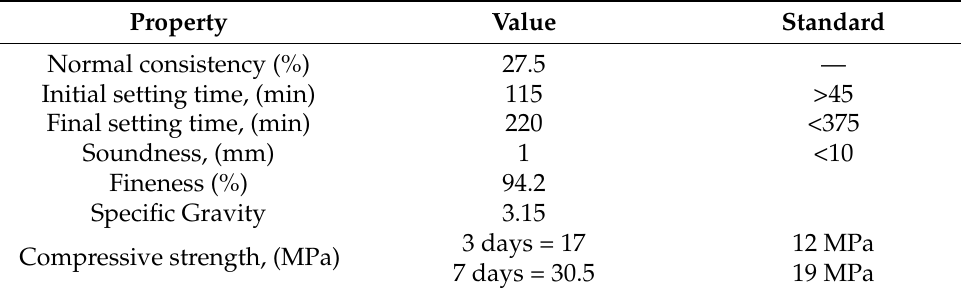
Table 1. Physical and mechanical properties of Portland